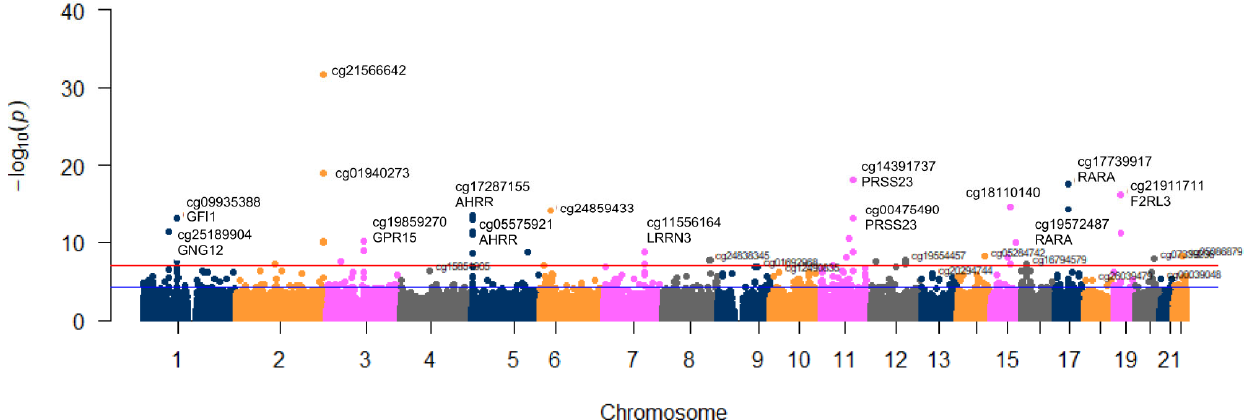
Figure 1. Manhattan plot of epigenome ‐ wide associations (EWAS) for tobacco smoking (5 levels) adjusted for covariates in the whole sample. Red line represents the EWAS significance level p = 9 × 10 − 8 . The blue line represents p = 1 × 10 − 5 . The GRCh37/hg19 assembly has been used.